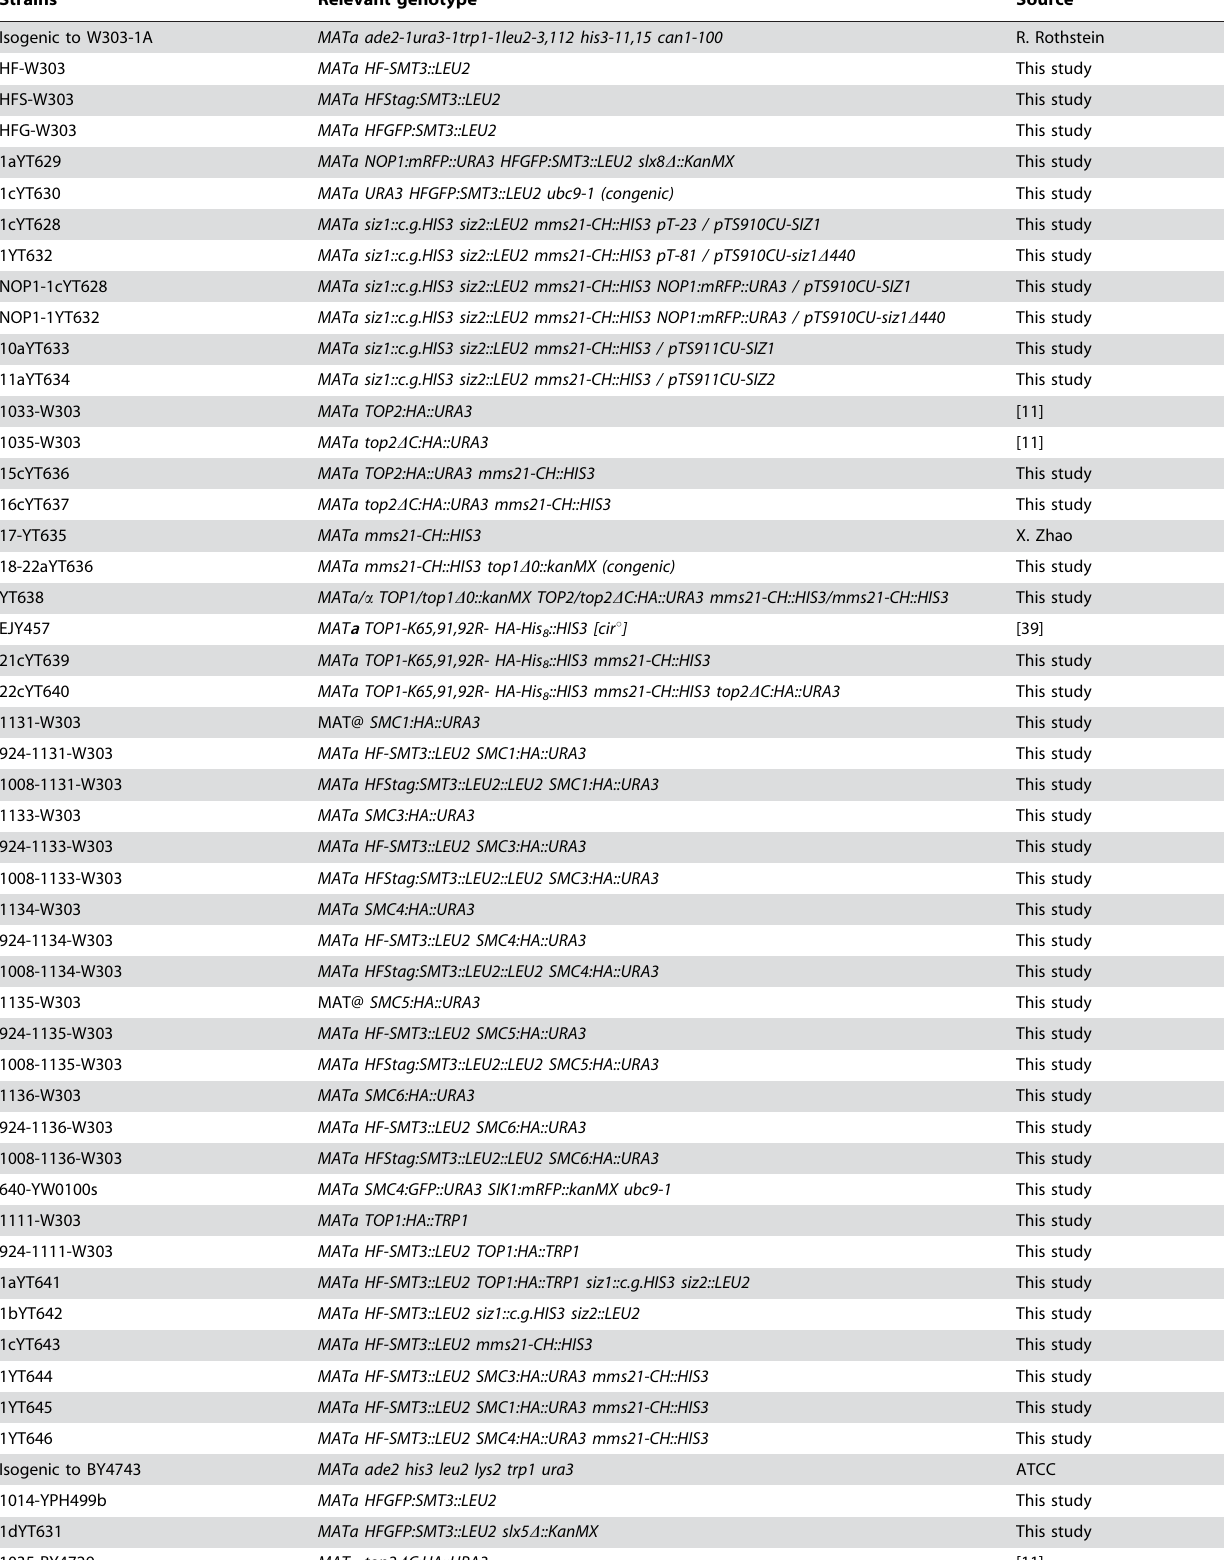
Strains Relevant genotype Source Isogenic to